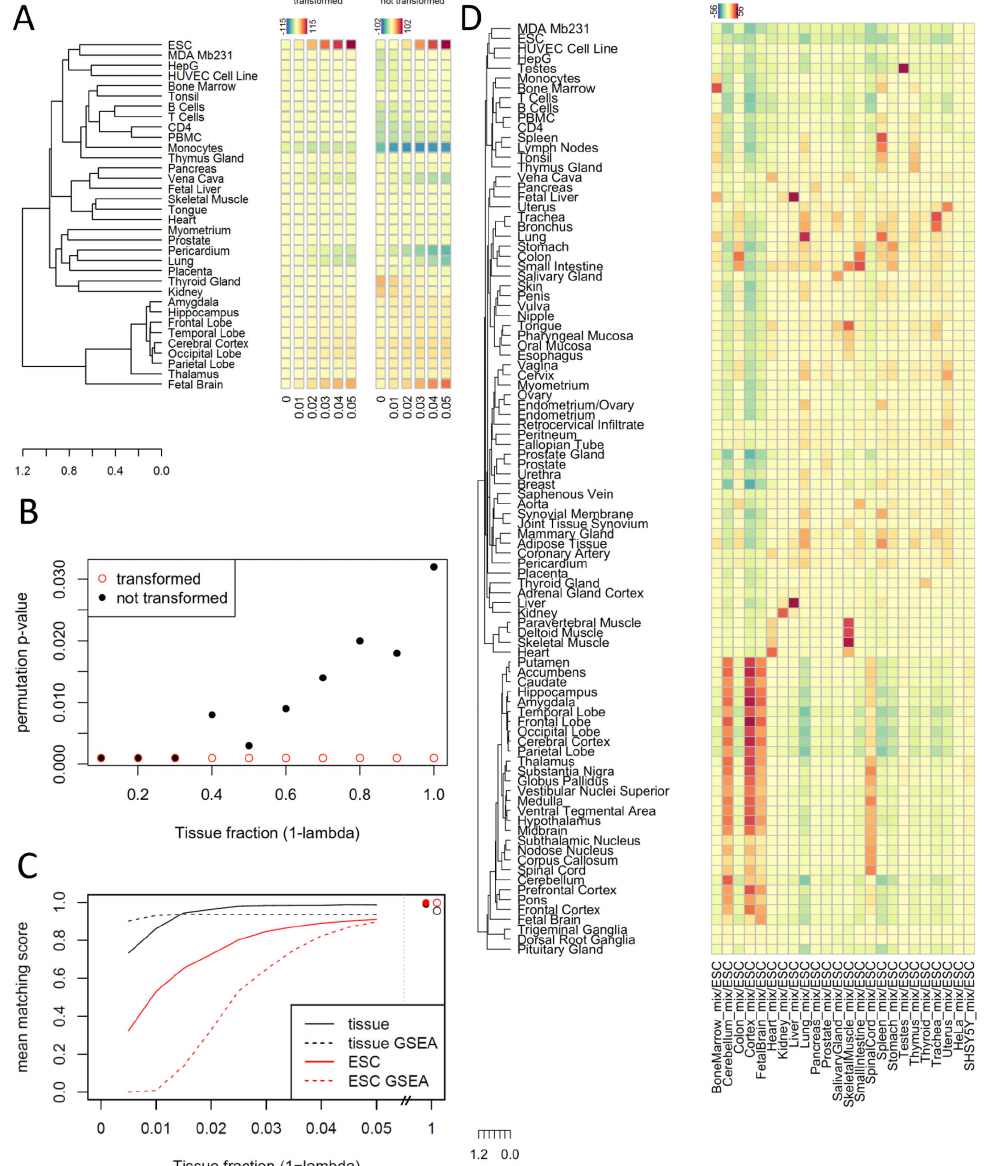
Figure 3. Performance evaluations with simulated data. (A) In the case of relatively high heterogeneity and comparably low signal strength, the spherical transformation increases sensitivity and specificity of the simulated effect, i.e. results in a strong and specific increase of the ESC score (left part). The results without spherical transformation (right part) are more heterogeneous. (B) The null-distribution obtained from re-sampling without spherical transformation is not meaningful in cases of high signal strength and low heterogeneity, leading to increasing p-values for increasing signal strength in simulated data. This effect does not occur when the spherical transformation is applied. Depicted are permutation p-values for the lung signature with (red dots) and without (black dots) spherical transformation. (C) The mean matching score of 21 simulated mixtures is compared between the implemented PhysioSpace algorithm and a classical GSEA based method. The matching score is defined as the quotient of the respective tissue (or ESC) score and the highest (lowest) score. It is truncated at a minimum of zero, avoiding negative values. While there are some differences between the two methods, especially for very low mixture values, the overall performance does not generally favor one or the other algorithm. (D) The PhysioScores of simulated mixtures of 97% ESCs with 3% of different tissues are visualized as an exemplary case, showing a very nice agreement with biological expectations. Correlations between different signatures are represented by the dendrogram on the left hand side as well as by simultaneous increasing PhysioScores in the columns of the heatmap-like representation. doi: 10.1371/journal.pone.0077627.g003 PLOS ONE |